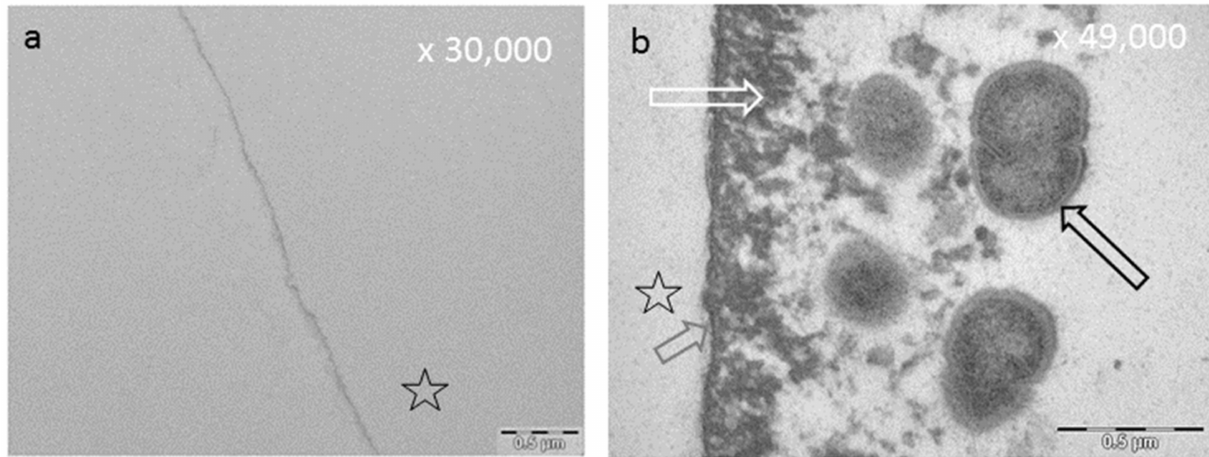
Figure 3. Representative TEM images of the 10 s ( a ) and the 24 h pellicle layer ( b ). The formation of a dense basal layer ( b , grey arrow) can already be visualized after a few seconds. After 2 h, there are granular and globular structures ( b , white arrow) which have absorbed onto this basal layer due to protein–protein interactions. As a result, an increase in pellicle thickness can be observed. ( b ) The result after 24 h biofilm formation. Please note the segmentation of the bacterial cell, indicating viability of the microorganisms ( b , black arrow). Please note that all TEM images (Figure 3, Figure 4, Figure 5, Figure 7, Figure 8 and Figure